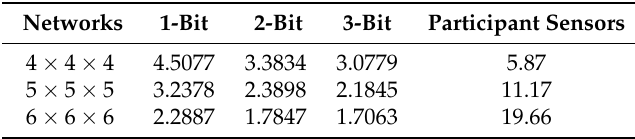
Figure 9. Target tracking performance of our scheme with 3-bit quantized measurements in different density networks. ( a ) Target tracking error with 3-bit quantized measurements; ( b ) posterior Cramer–Rao lower bound (PCRLB) with 3-bit quantized measurements. Average tracking errors and average number of participant sensors in different density